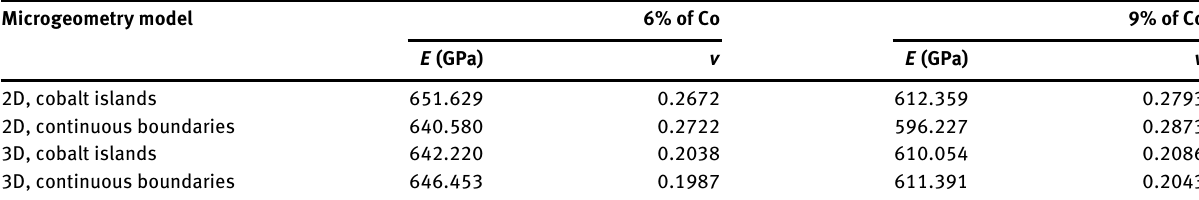
Table 1: Young moduli E and Poisson ratios v with respect to different cobalt content and different microgeometry model. Microgeometry